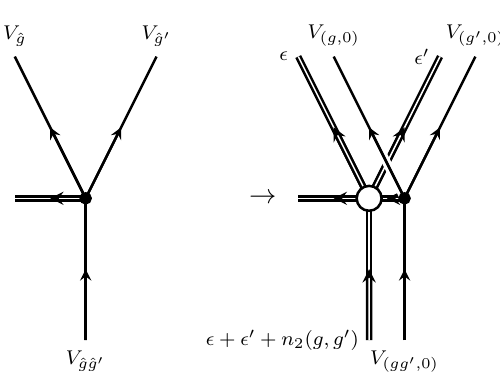
Figure 34 . Gauge-(cid:12)xing: a graphical representation of the partial gauge-(cid:12)xing procedure used in computing the tetrahedron contribution of the ^ G Gu-Wen phase decorated by an extra 2-form (cid:13)at connection (cid:12) 2 . Left: a choice of gauge is the same as a choice of basis vector in the space of junctions between line defects in the full ^ G category, possibly with an extra center line. Right: we identify V ’ V (cid:10) V g; 0 and identify V with the corresponding elements I or (cid:5) of the ( g;(cid:15) ) (1 ;(cid:15) ) (1 ;(cid:15) ) center. We then express a general junction canonically in terms of a choice of junction between line defects labelled by G elements. The double lines denote the center elements. The empty circle represents any choice of how to connect the center lines in a planar way.